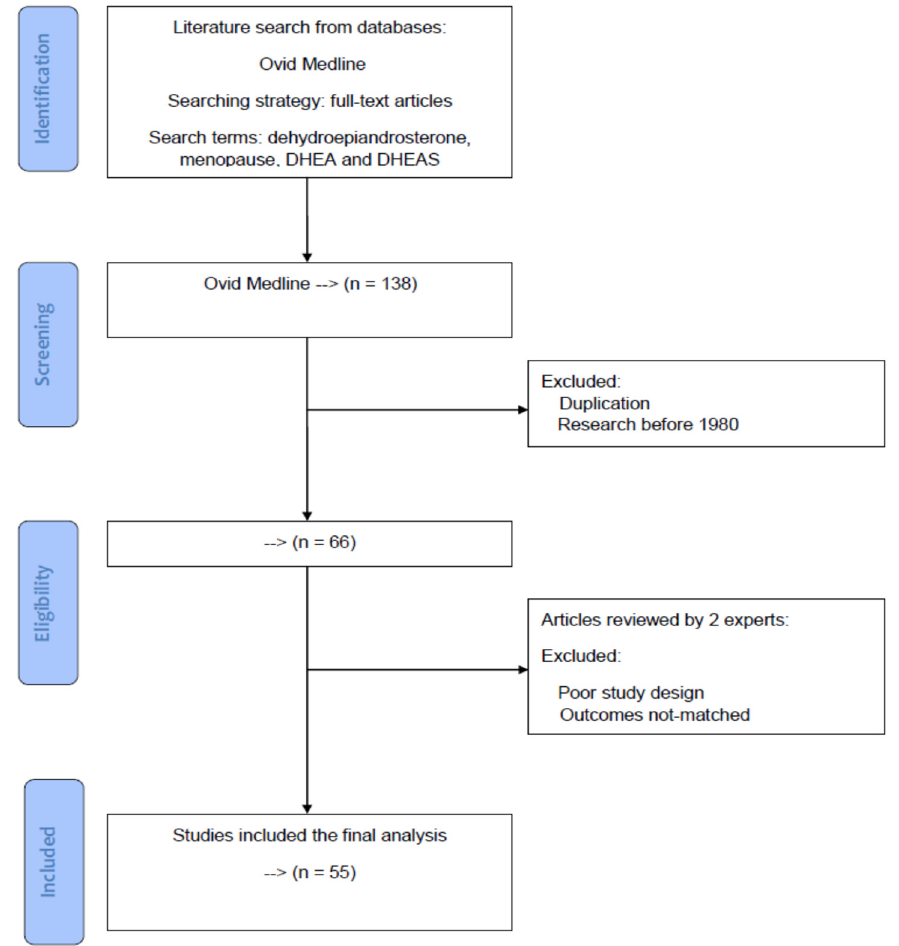
Figure 1. A diagram of article selection to illustrate the processes of database identification, article screening, confirmation of eligibility, and final inclusion based on the PRISMA statement.